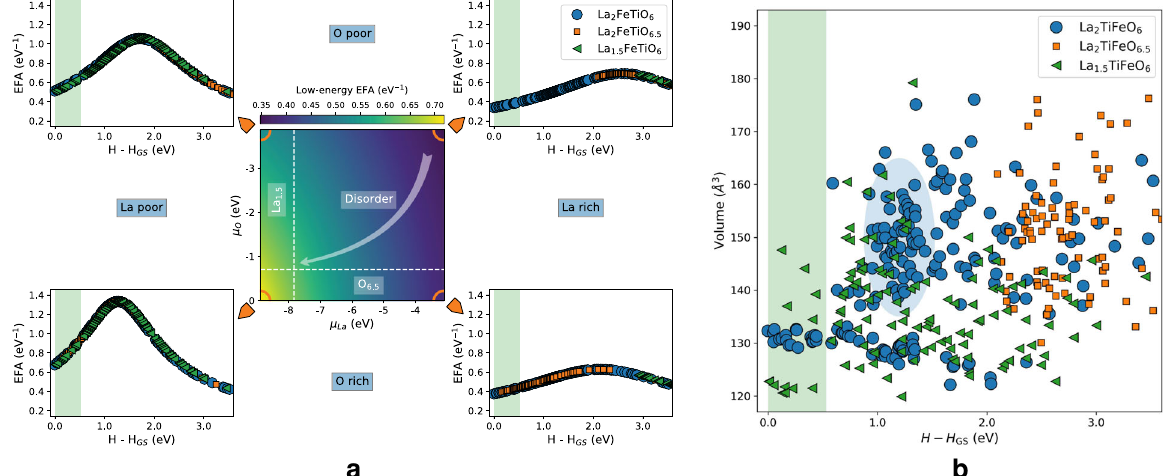
Fig. 4 EFA analysis of La 2 TiFeO 6 . a Entropy forming ability analysis of AIRSS results including different stoichiometries in the spectrum. The EFA re fl exes the spectrum density and depends on the defect formation energies and hence on the chemical potentials of defects, μ O and μ La